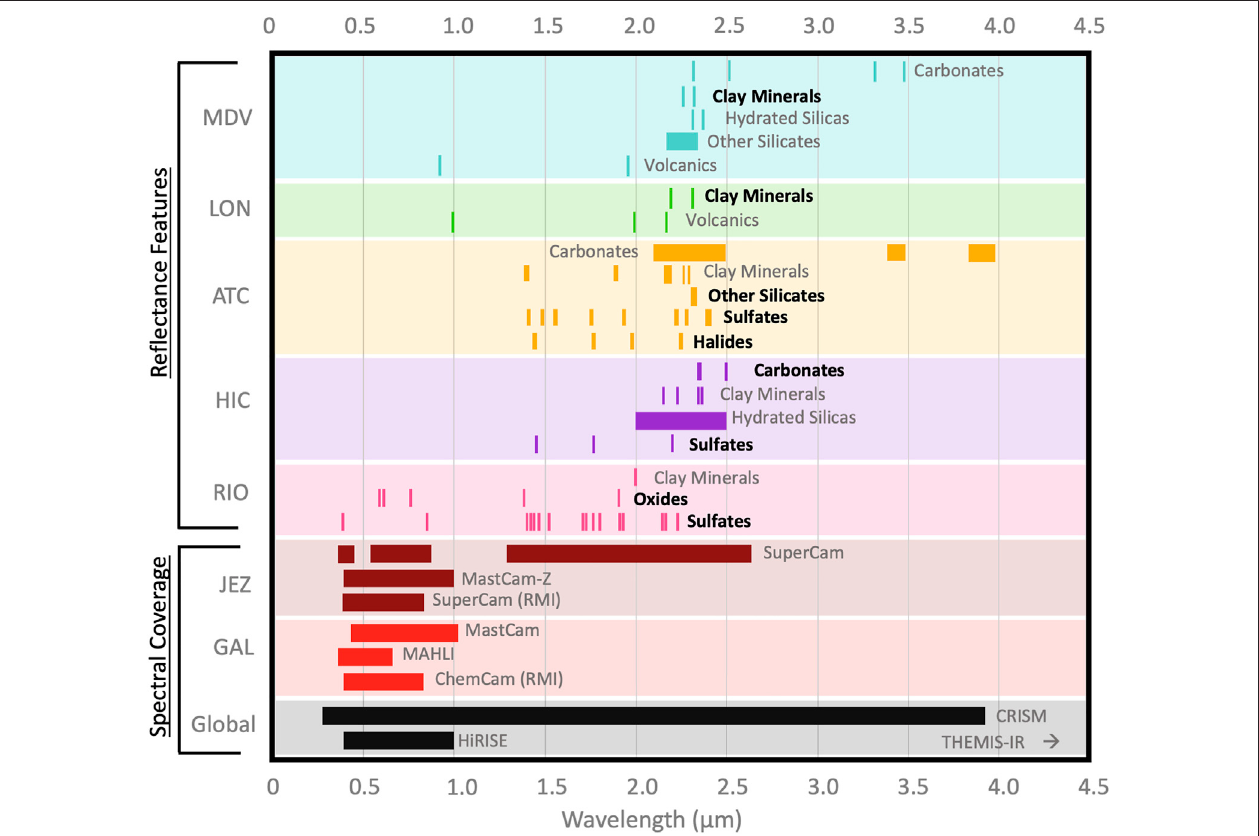
FIGURE 7 | Characteristic spectral features (wavelength in um) of dominant mineral groups at terrestrial analogs measured with VNIR re fl ectance spectroscopy compared to the wavelength coverage of Mars-based passive imagers. Preserved lipid biomarkers have been detected in mineral groups with bolded names. Mineral spectrafortheMcMurdoDryValleyswereanalyzedinalaboratory(Bishopetal.,2014),spectraforallotheranalogsweredeterminedremotely. SupplementaryTables S1,S3,S5 catalog relevant details on Mars instruments, lipid biomarkers, and mineral spectra,